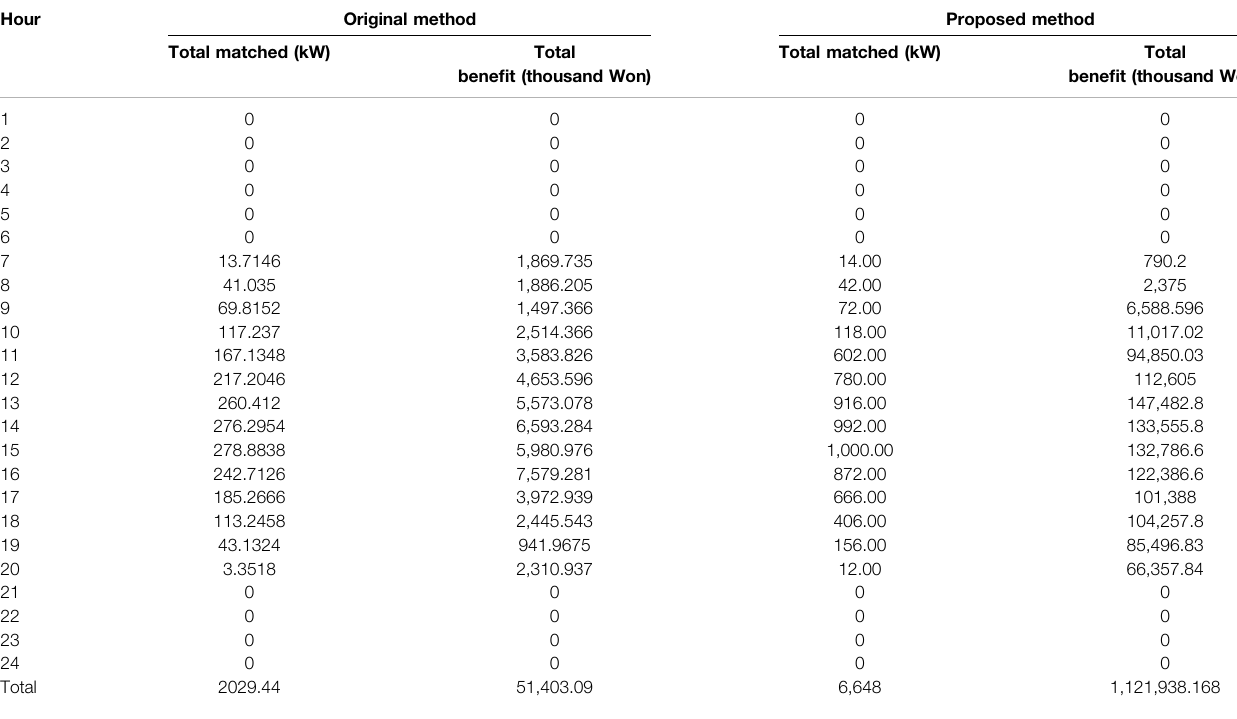
TABLE 2 | Comparison of results of original and proposed methods: Case